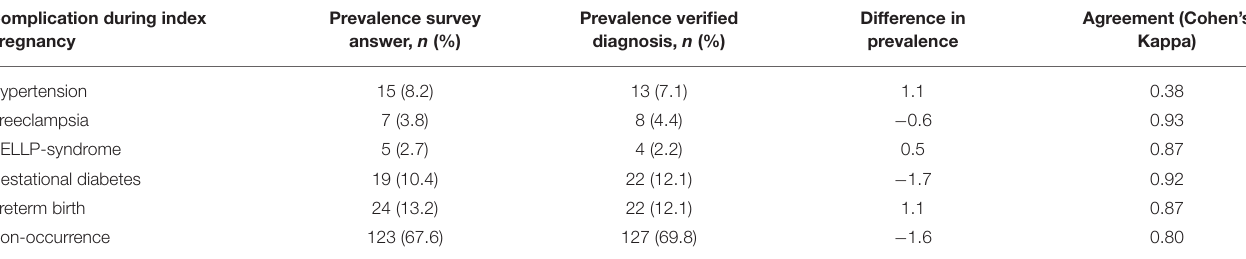
TABLE 7 | Comparison of complications between survey answers and verified diagnoses for singleton birth after frozen-thawed embryo transfer. Complication during index